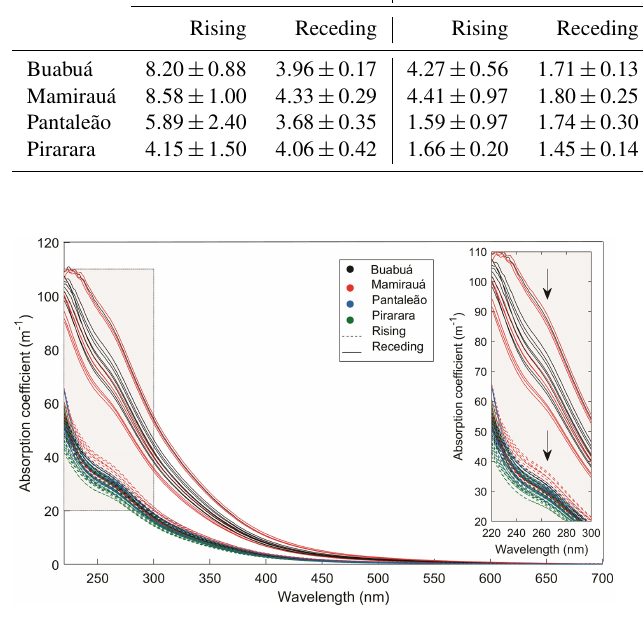
Figure 3. a CDOM absorption spectra collected in the Buabuá (black), Mamirauá (red), Pantaleão (blue) and Pirarara (green) lakes during rising (solid line) and receding (dash line) limb of hydro- graph. The gray rectangle represents the zoomed-in area on the right-hand side. The black arrows indicate the shoulder between 245 and 290nm.